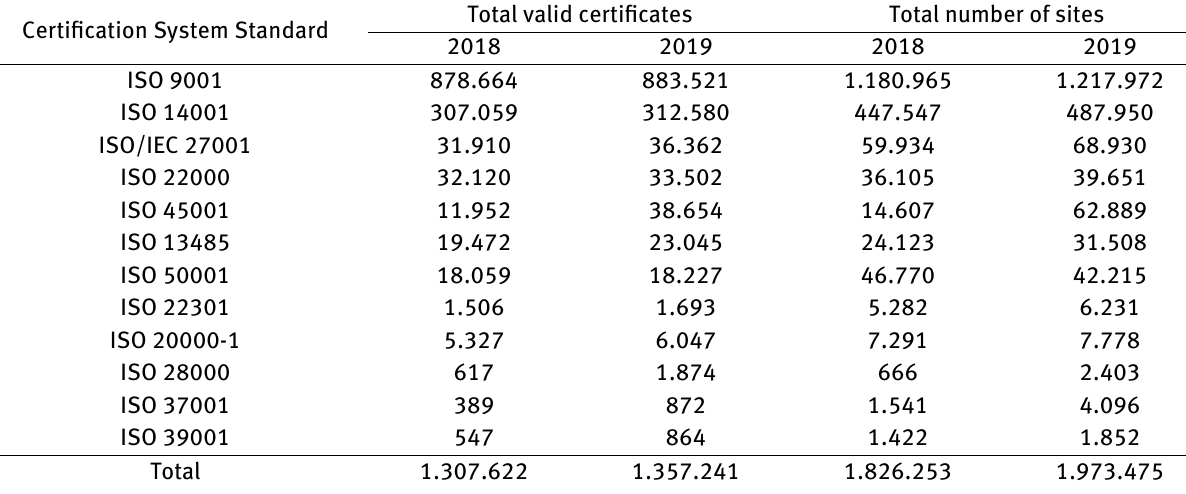
Table 1: Number of valid certificate and site number of certification system standards (2018-2019)